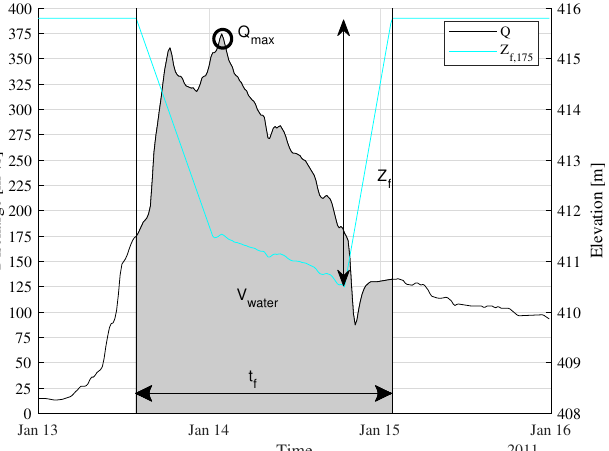
Figure 5. Discretisation of continuous time-series of the hydrograph (Q) and water surface elevation (Z f ) into five parameters, exemplary for one event of scenario Z f,175